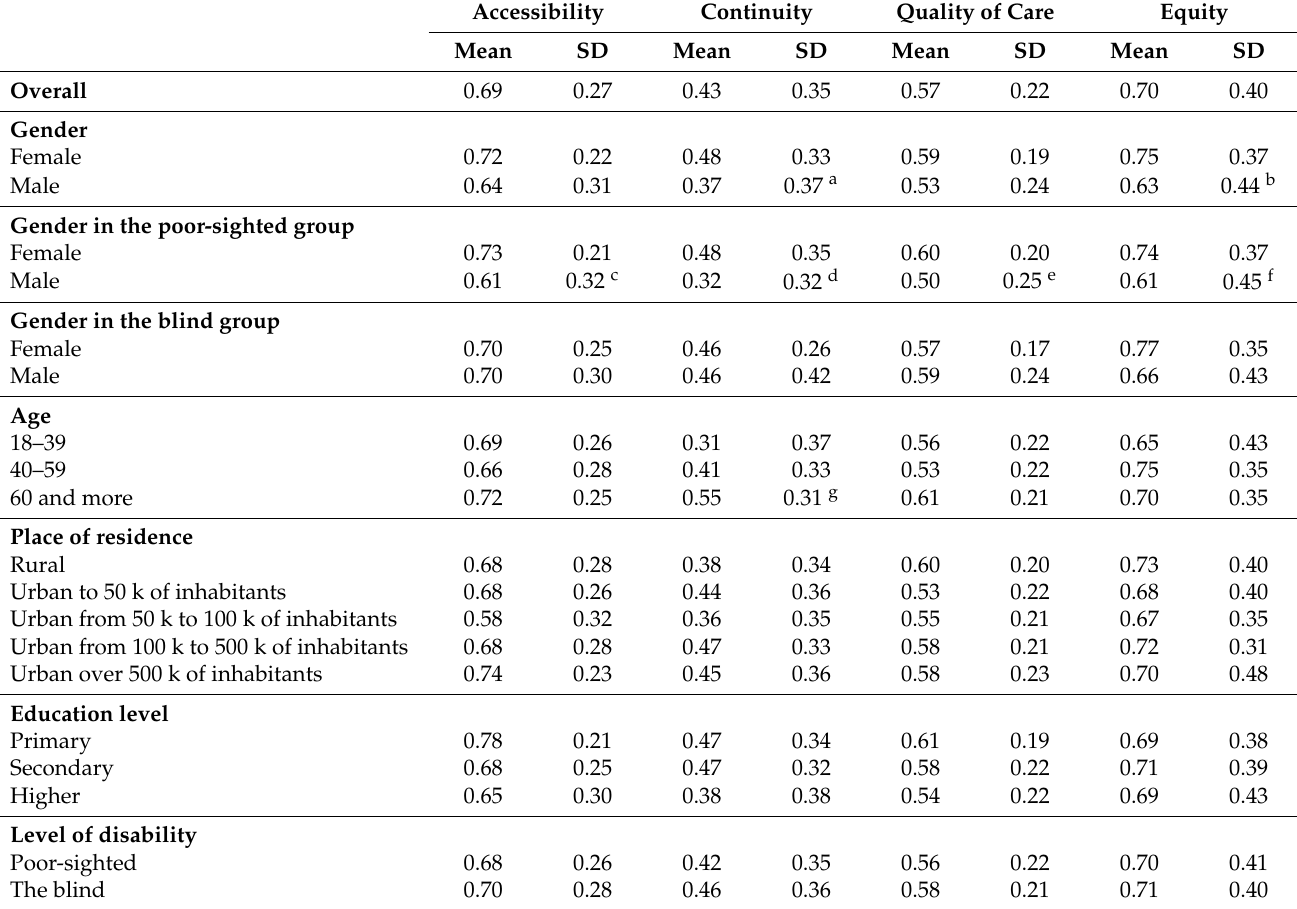
Table 1. Expectations towards PHC according to sociodemographic, health-related and disability variables among PVIs. Accessibility Continuity Quality of